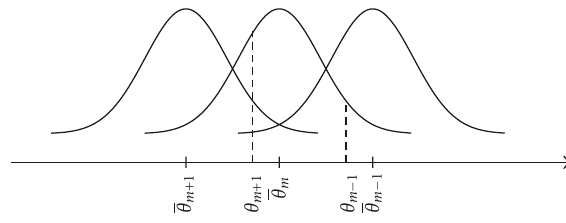
Figure 1: Distributions of θ ( m + 1), θ ( m ), and θ ( m −